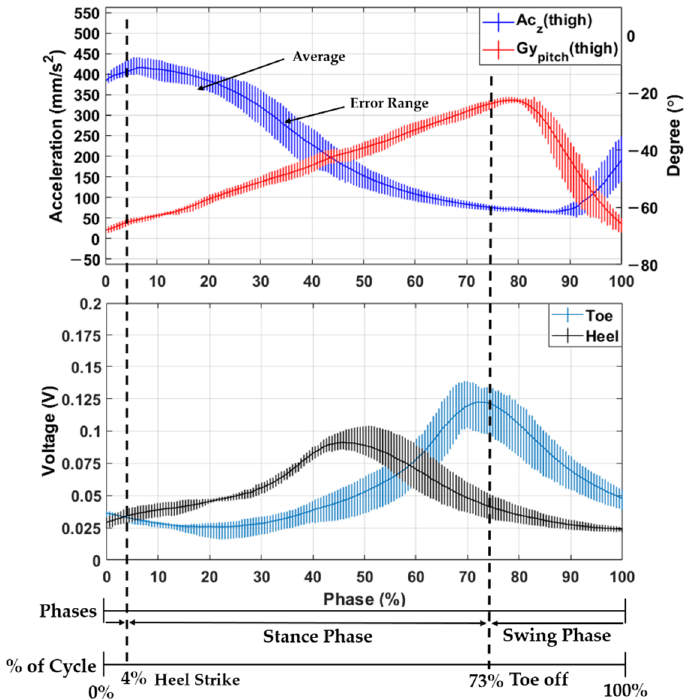
Figure 3. The average and error range of data from the IMU sensor and foot sensor during 50 gait